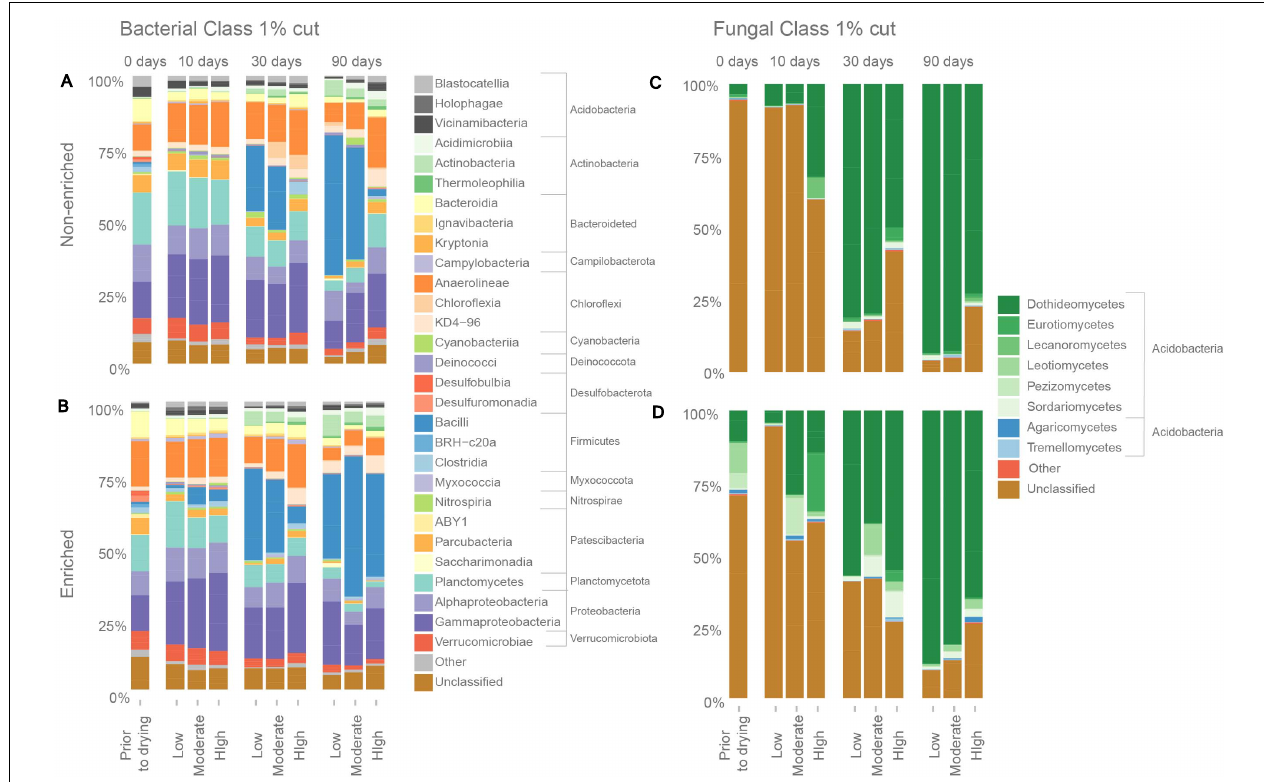
FIGURE 3 | Relative average ( n = 3) abundance of major bacterial classes in (A) non-enriched and (B) enriched sediment, and relative abundance of major fungal classes in (C) non-enriched and (D) enriched sediment under various drying intensities (low, moderate, and high) and after different drying durations (0, 10, 30, and 90